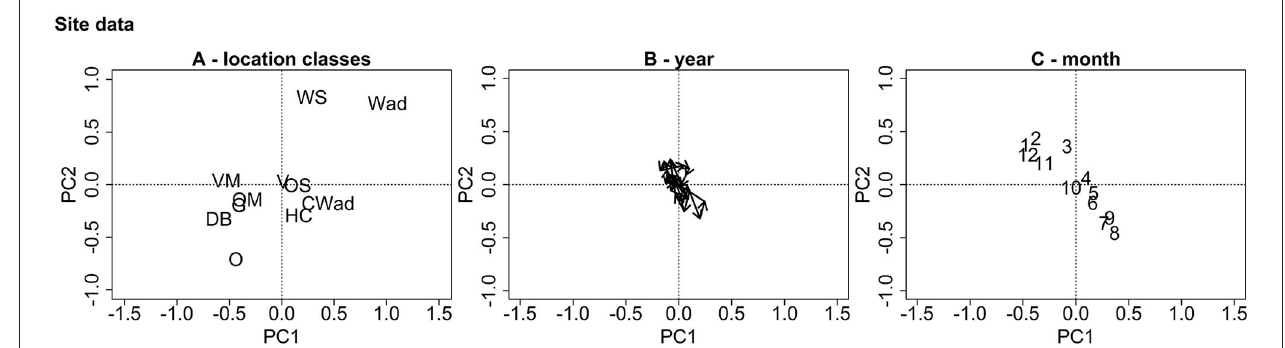
FIGURE 4 | PCA ordination plots for the site data. Subfigure (A) displays the ordination centers for the location classes (WS, Westerschelde; Wad, Wadden Sea; OS, Oosterschelde; VD, Voordelta; HC, Holland Coast; CWad, Coastal Wadden Sea; VM, Veerse Meer; G, Grevelingen; OM, offshore mixed; O, Offshore; D, Doggerbank), (B) the ordination centers for the years and (C) the ordination centers for the months. The plots are dominated by two opposite, diagonally oriented gradients representing the location classes and